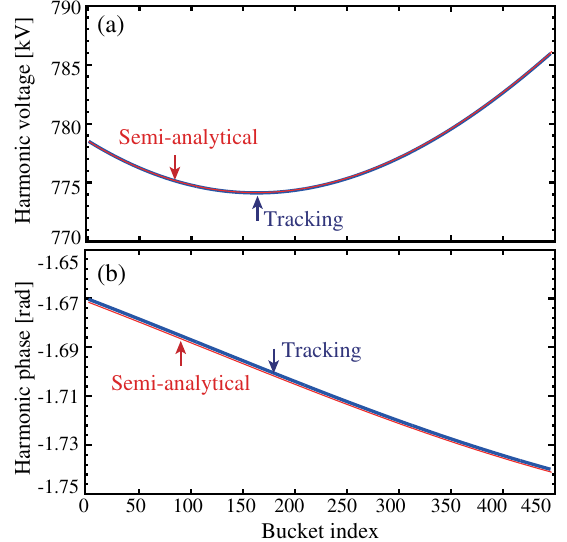
FIG. 4. Variations in the third-harmonic rf voltage due to bunch gaps, which were calculated using the semianalytical method (red) and tracking simulation (blue), respectively. Pictures (a) and (b) show the amplitude and phase, respectively. Abscissa in- dicates the index of the rf buckets, which ranges over one of the bunch trains. We assumed a beam current of 500 mA with the standard fill pattern of the KEK-LS (two bunch trains, n 30 ). n g ¼